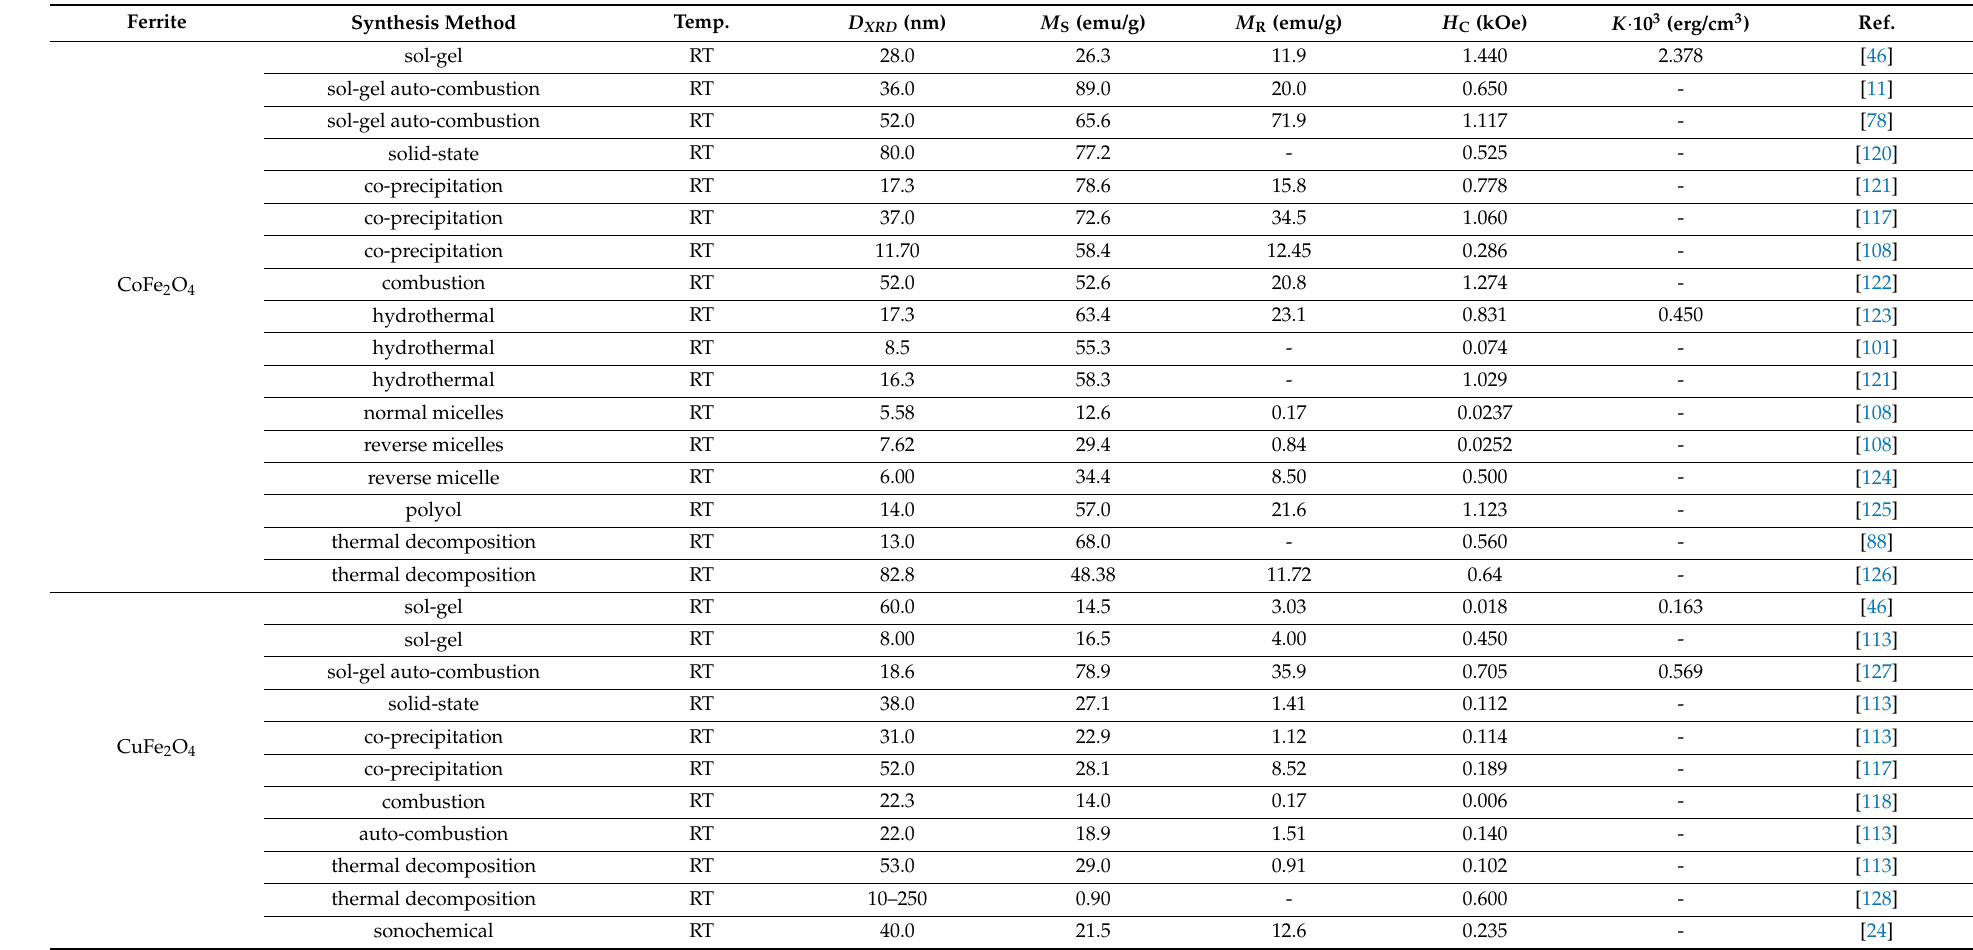
Table 1. Average crystallites size ( D ), saturation magnetization ( M S ), remanent magnetisation ( M R ), coercivity ( H C ) and anisotropy constant ( K ) of CoFe 2 O 4 , CuFe 2 O 4 , MnFe 2 O 4, NiFe 2 O 4 , ZnFe 2 O 4 , produced by different synthesis methods; RT-room temperature.